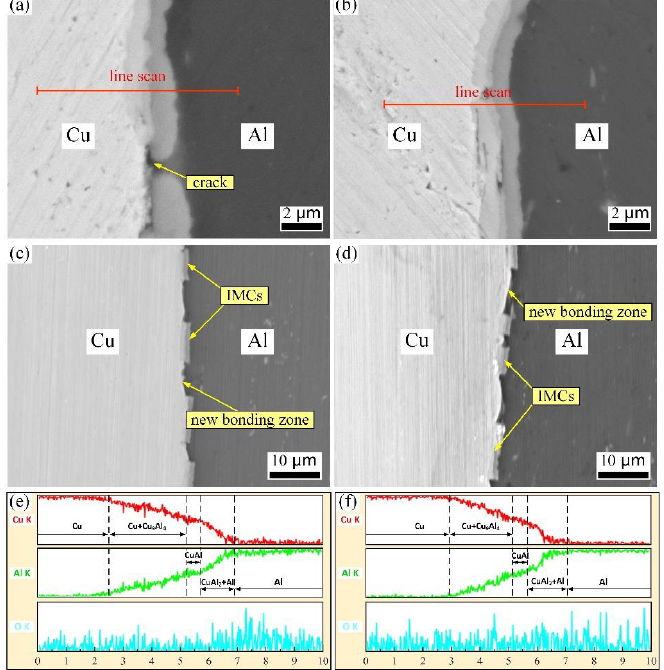
Figure 3. SEM images of the Cu/Al clad plates: ( a , c ) at peak, ( b , d ) at trough, ( a , b ) by CCRB, ( c , d ) by FRB; ( e ) and ( f ) are the EDX line scanning results along the line in ( a ) and ( b ), respectively.